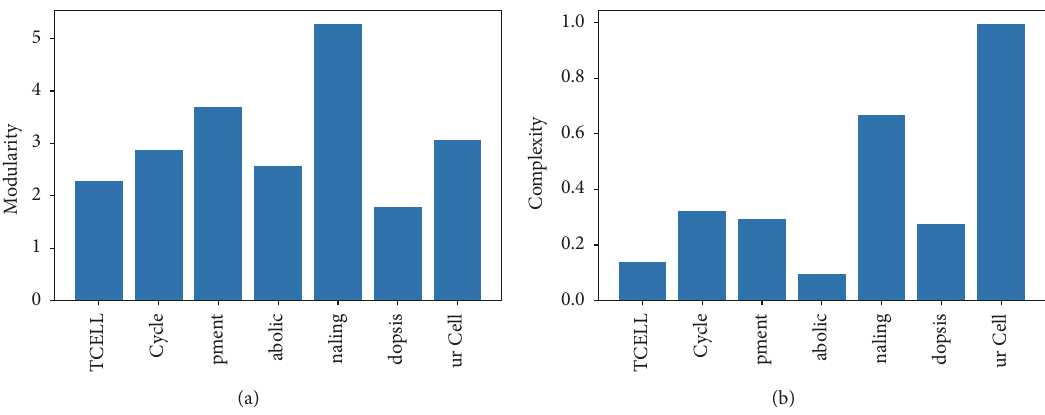
Figure 12: Modularity and complexity of seven biological